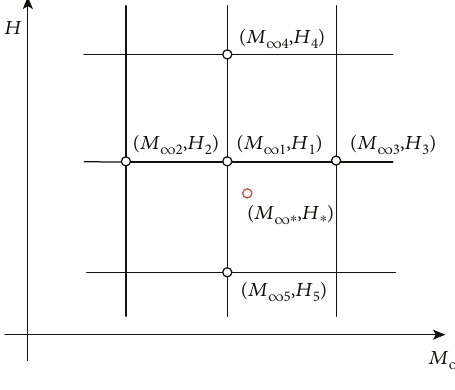
Figure 9: Selection of interpolation